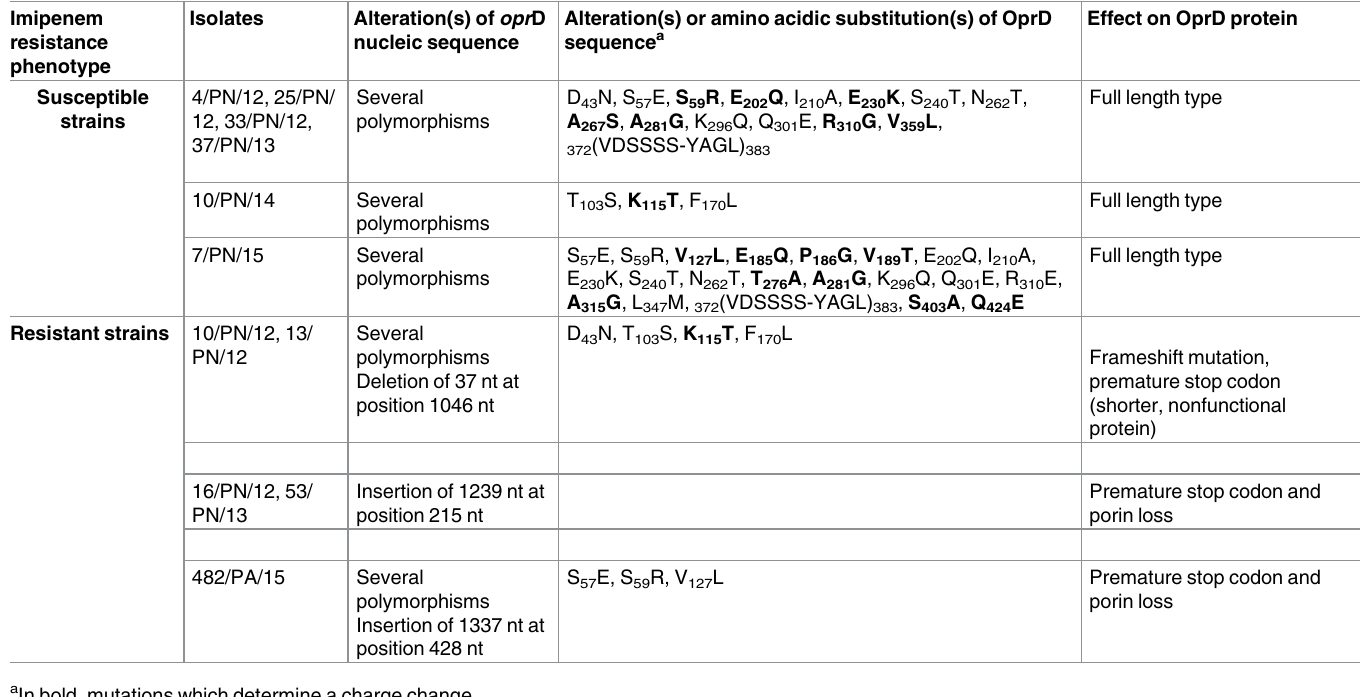
Table 4. Different OprD types and mechanisms of imipenem resistance detected among the P . aeruginosa isolates. Imipenem